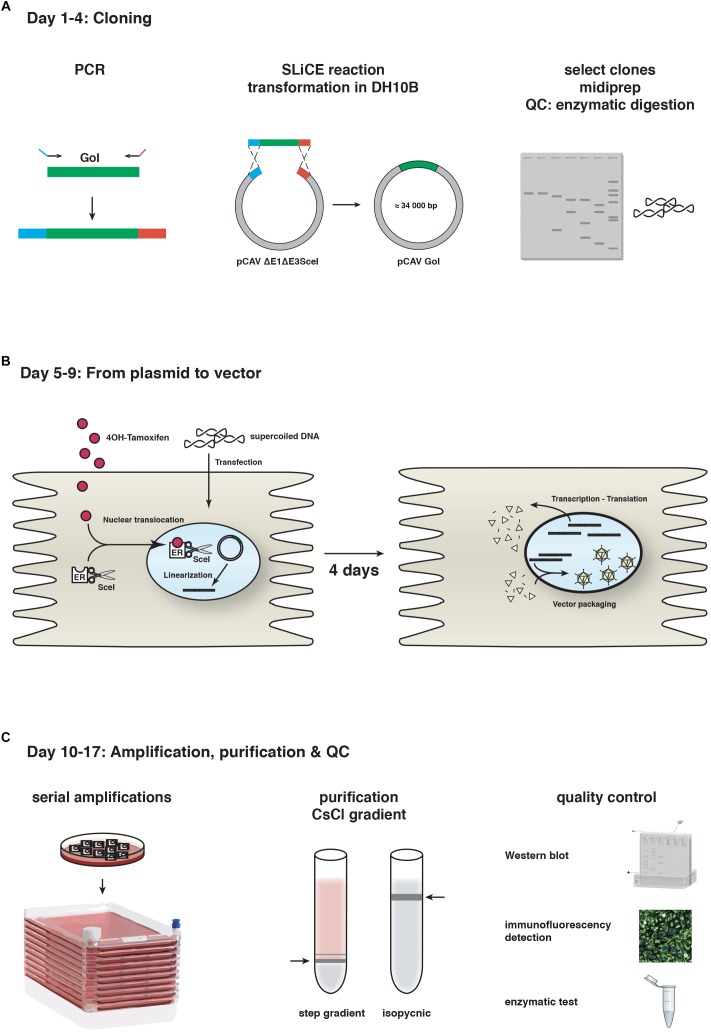
CAV-2 vector production. A schematic representation of the steps and timeline for (A) cloning using SLiCE, (B) vector generation from plasmid using SceI-expressing cells, and (C) vector amplification in cell factories, purification and quality control (QC). GoI, gene of interest.